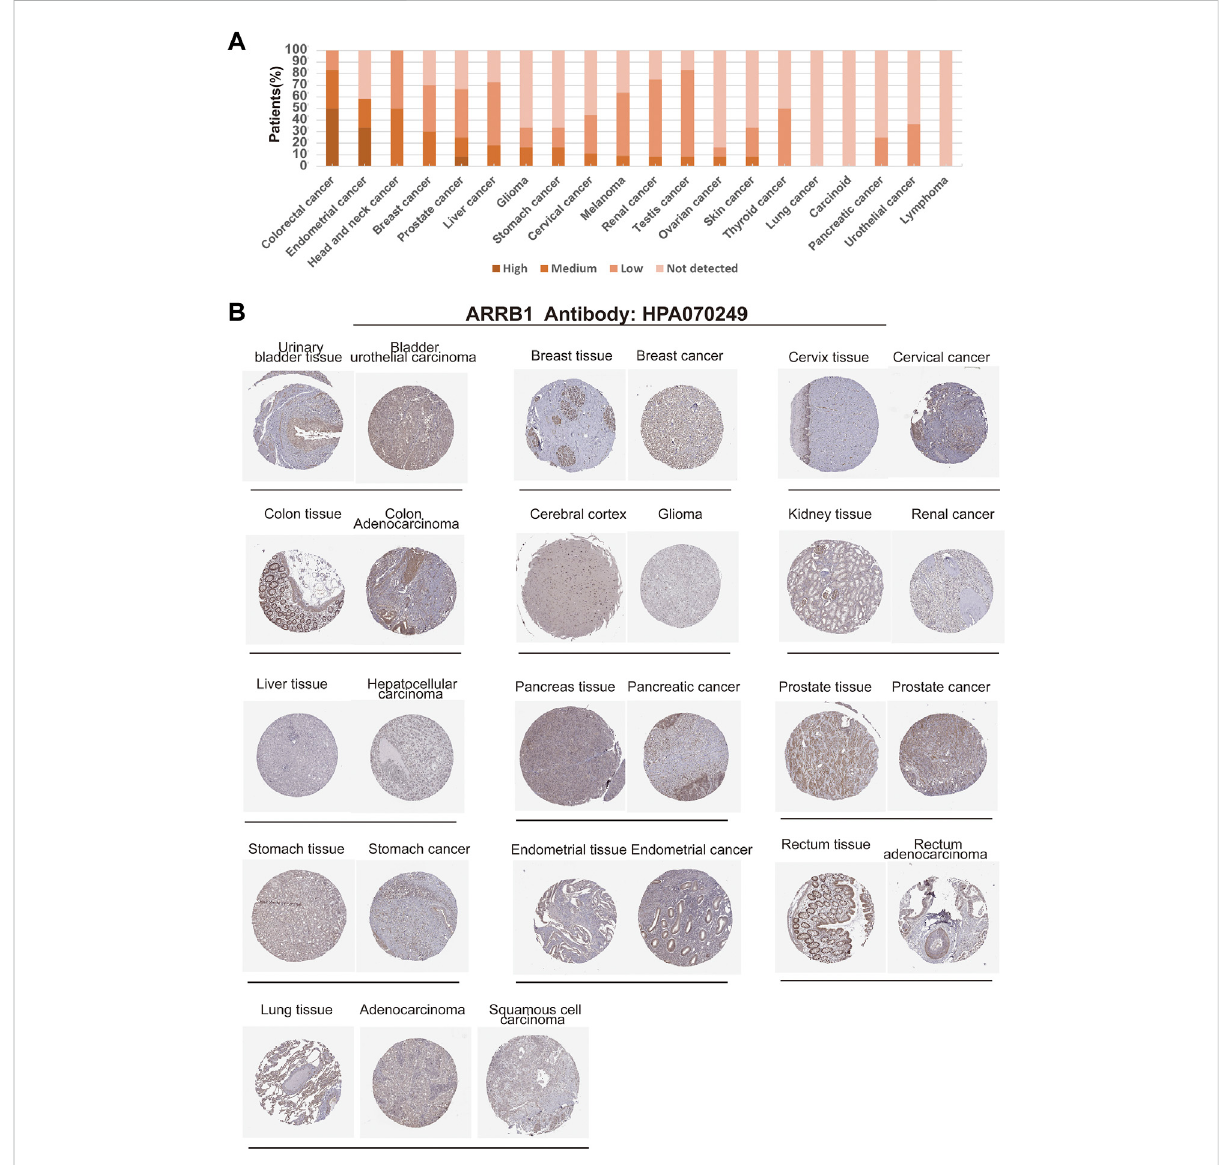
FIGURE 2 Expression of ARRB1 protein in various cancer tissues in the HPA database. (A) Percentage of patients with high, medium or low ARRB1 protein expression levelsindifferent cancers intheir respective tumors. (B) Immunohistochemical imagesofARRB1 expression invariouscancer tissues and corresponding normal